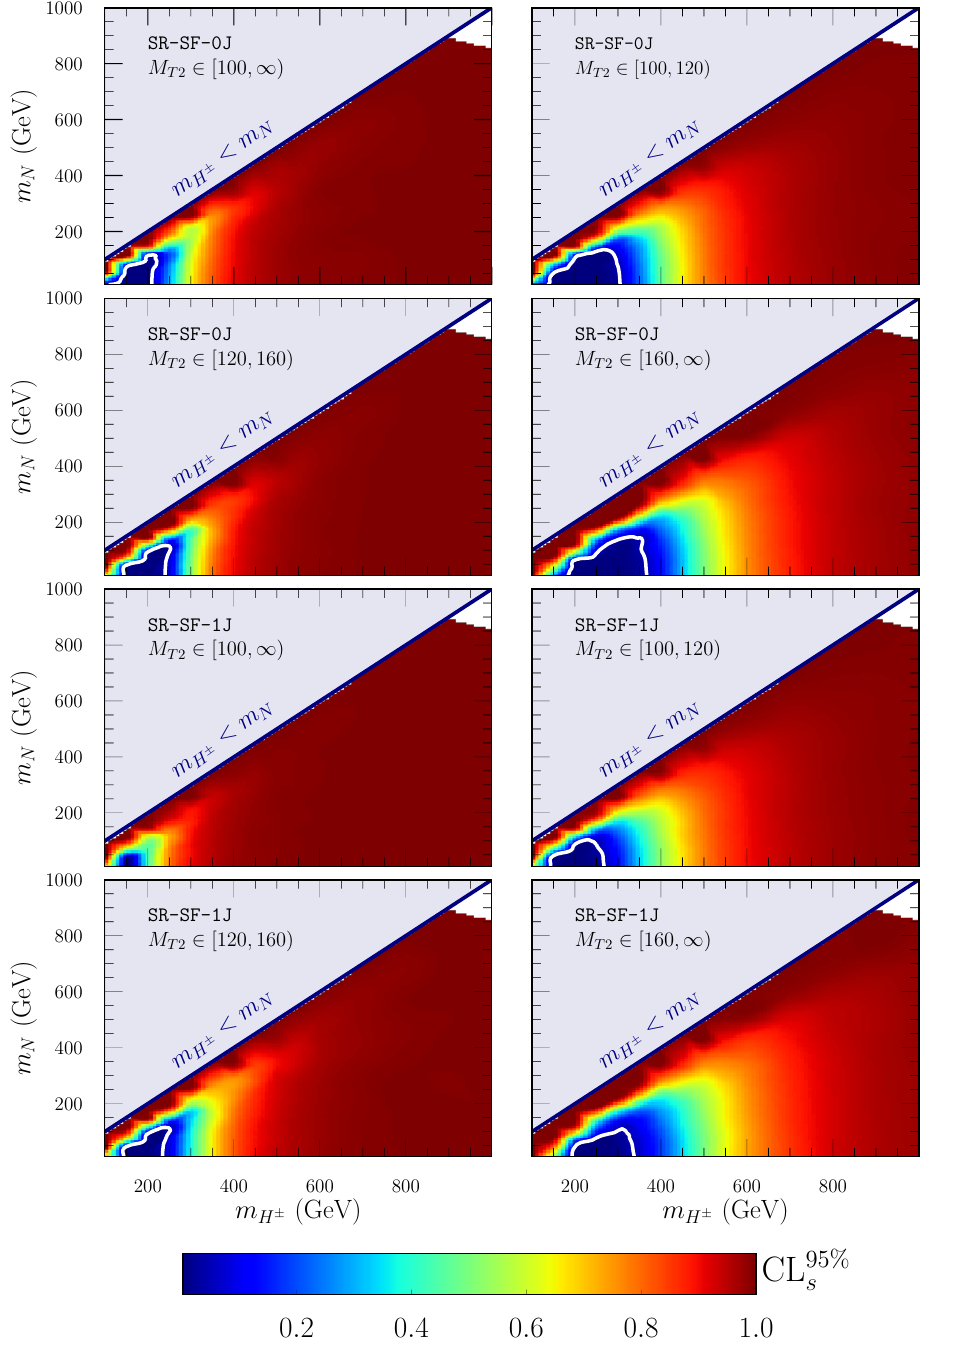
) and H ± > m N required by H ±